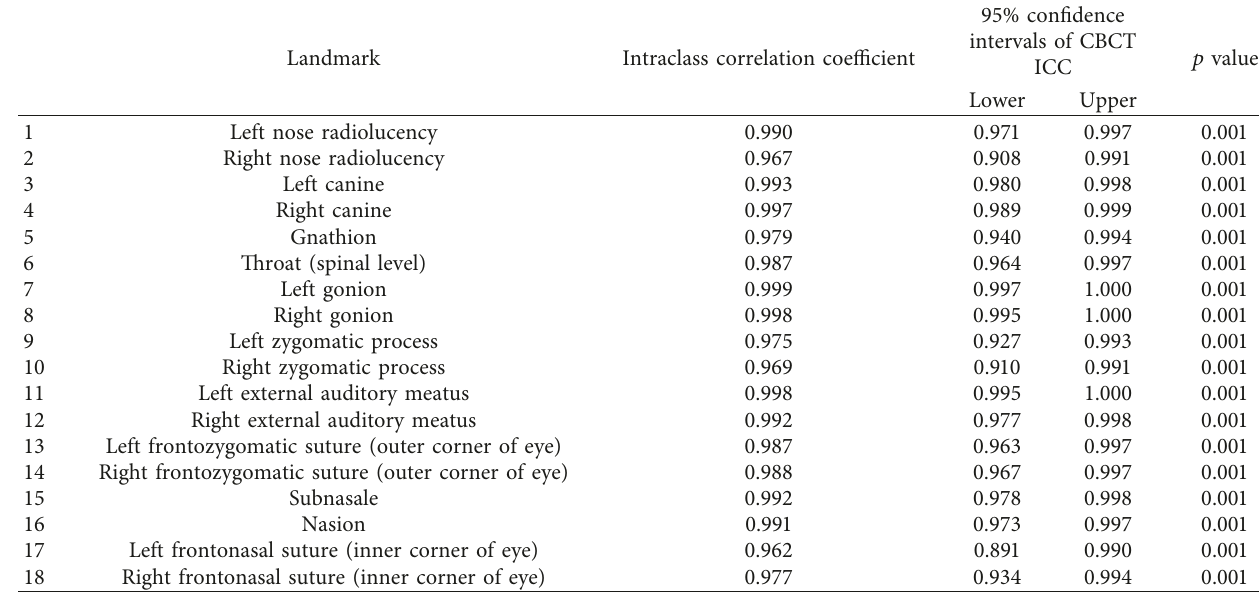
Table 5: Intraclass correlation coefficients (ICC) of CBCT landmarks, lower and upper limits of their 95% confidence intervals, and their corresponding p